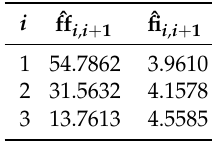
Table 4. Maximum likelihood estimation (MLE) estimates of the parameters of the model using differential evolution (DE).